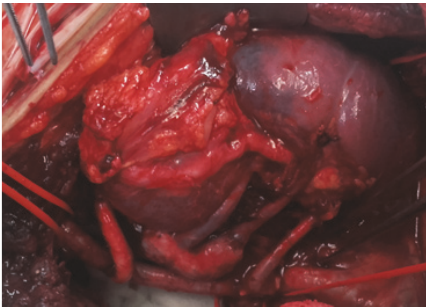
Figure 6: Kidney after reperfusion, all three vascular anastomoses. normal flow with resistive indices between 0.65 and 0.8. The two renal arteries and veins had normal spectral waveforms, with a final impression of normal appearances of right iliac fossa transplant kidney.